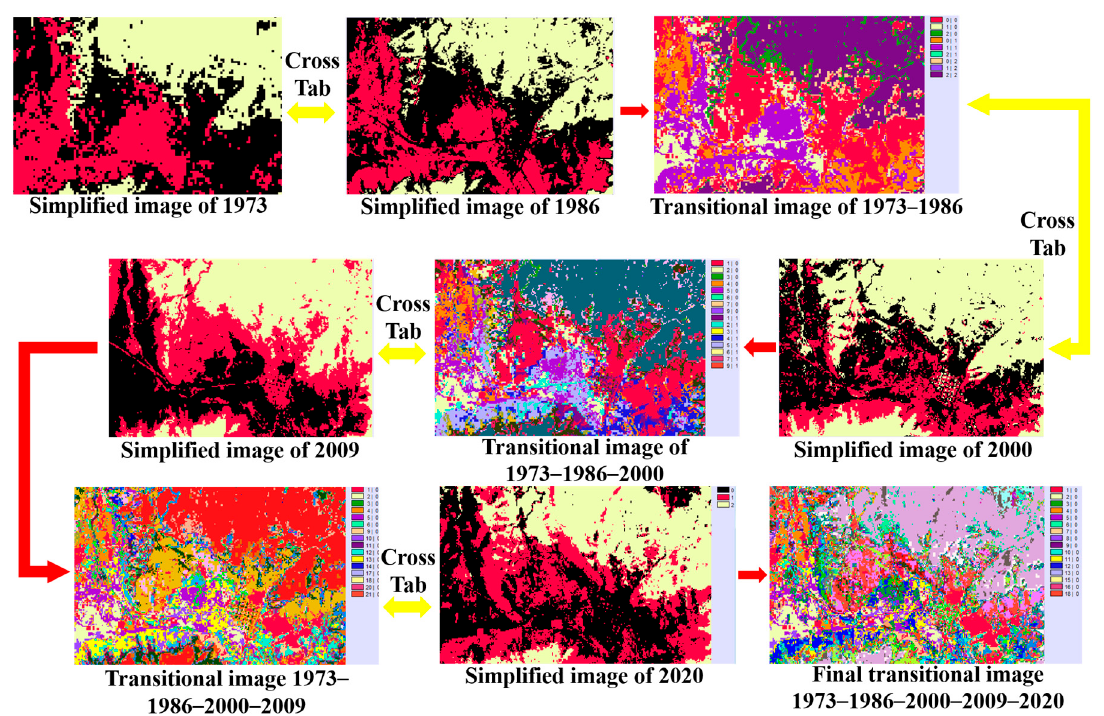
Figure 2. Summarized process for the delimitation of successional categories. ( a ) The first LULC image classified by MAXLIKE ( b ) is reclassified into three simplified categories: 0 (simplified category of anthropogenic activities), 1 (rangeland), and 2 (submontane scrubland, Pine–Oak forest or tascate forest, depending on the most appropriate for each Ejido). ( c ) Other LULC images are reclassified in the same way. ( d ) A cross-tabulation is made, comparing the simplified image of 1973 with that of 1986, which results in a change transition image for 1973–1986 with nine categories. This is compared to the following simplified image (2000), resulting in a new transition image. The process continues until a final transition image is obtained, from